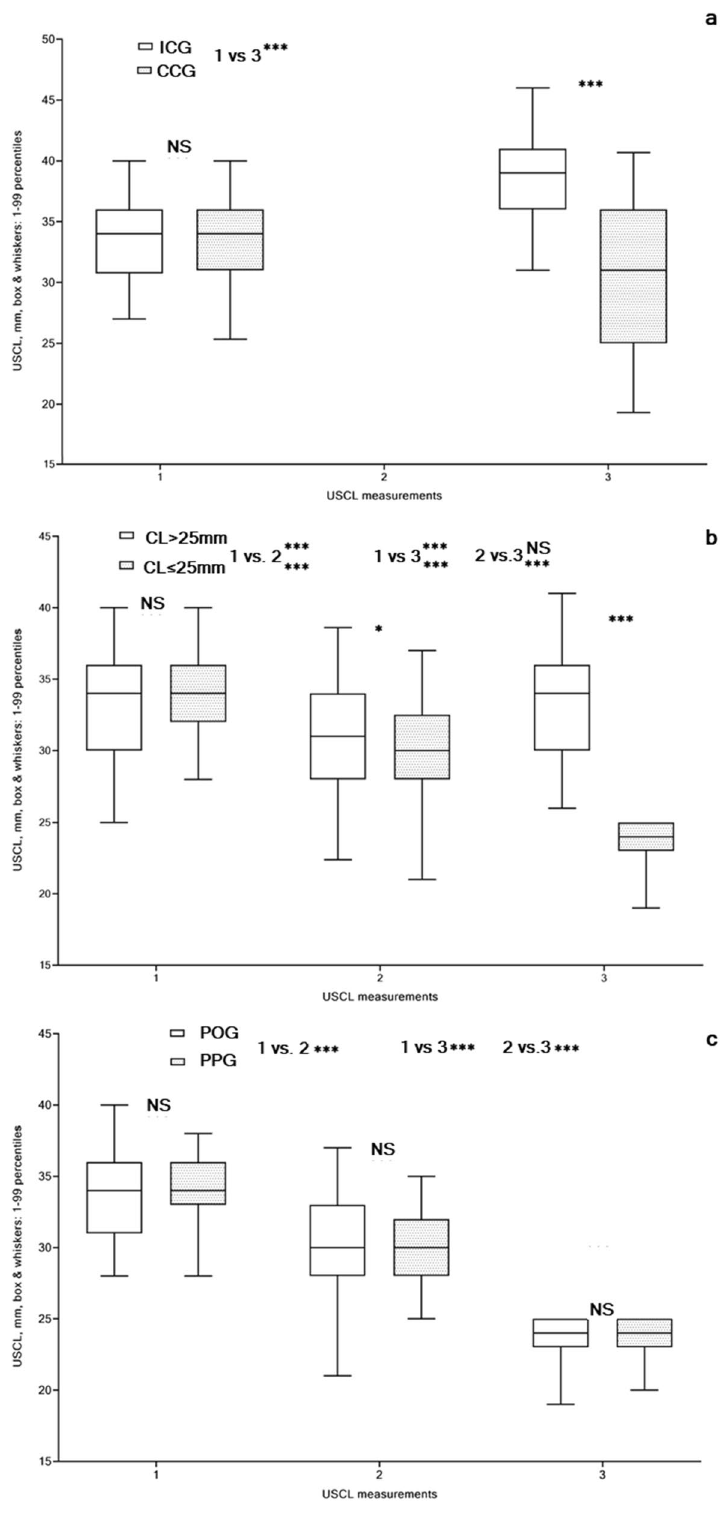
Figure 4. Ultrasound cervical length (USCL) assessed in non-pregnant women before (1) and after (2) cervical conization, and during pregnancy (3), unit: mm, box & whiskers, 1–99 percentiles) in asymptomatic women with singleton pregnancies: ( a ) Intact Cervix (ICG) vs. Cervical Conization (CCG), groups; ( b ) Adequate cervical length (CL > 25 mm) vs Short cervix (CL ≤ 25 mm), groups; ( c ) Progesterone-only (POG) vs Progesterone-Pessary (PPG),